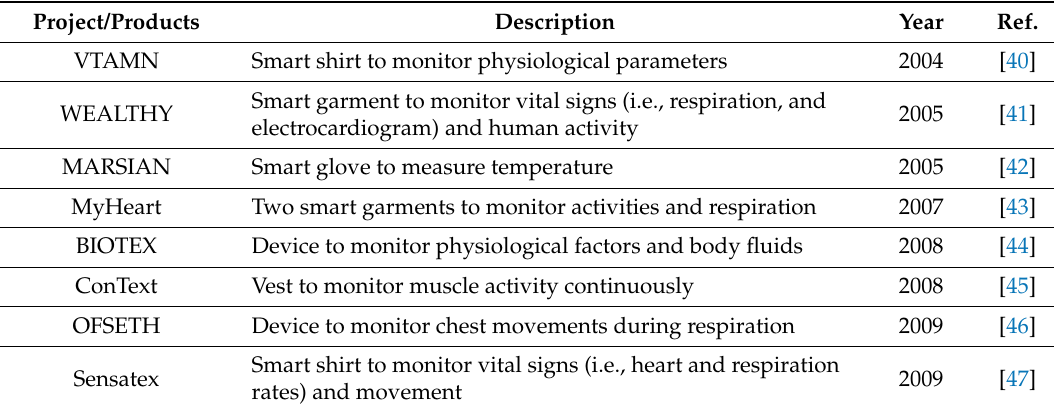
Table 2. Some textile sensors and systems for medical